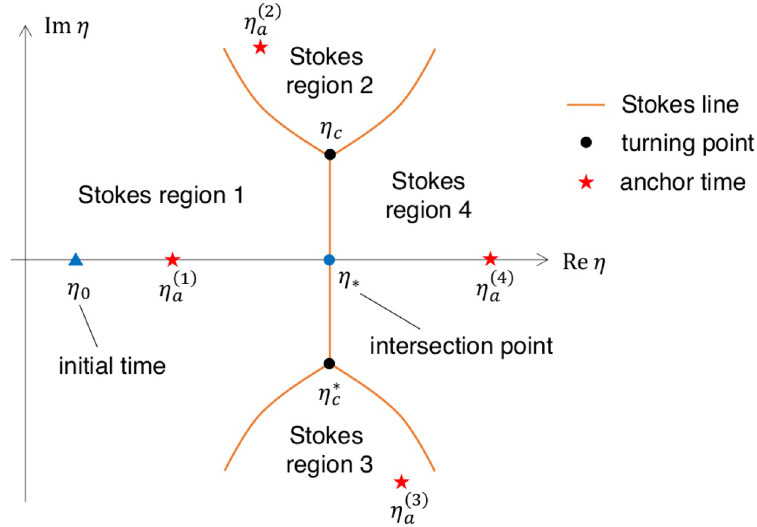
Figure 1 . An illustration showing how the complex plane (conformal time η ) is divided into Stokes regions, bounded by Stokes lines (orange curves), that terminate on turning points (black dots) or extend to infinity. This structure is totally determined by the roots of ω ( η ) and its paths of steepest descent/ascent. In each Stokes region, an EWKB basis solution ψ ( i ) an anchor time η ( i ) a (red